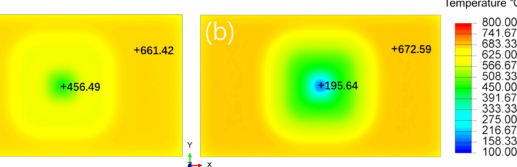
Figure 22. The simulated temperature distribution of the blank after primary cooling. ( a ) TPP-S; ( b ) TPP-F.